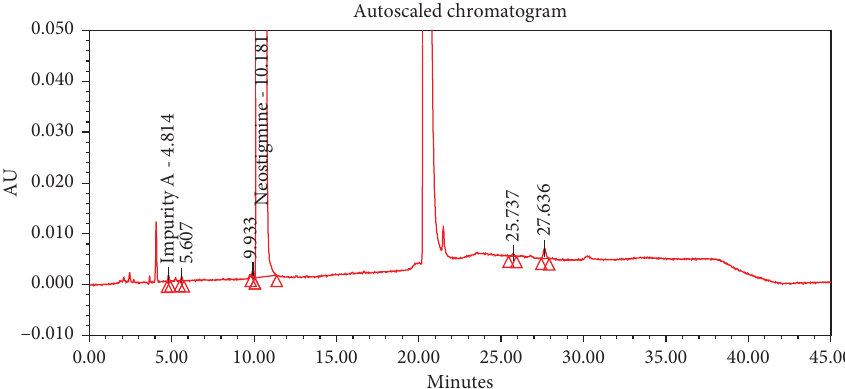
Figure 10: Chromatogram of control sample of neostigmine methylsulfate